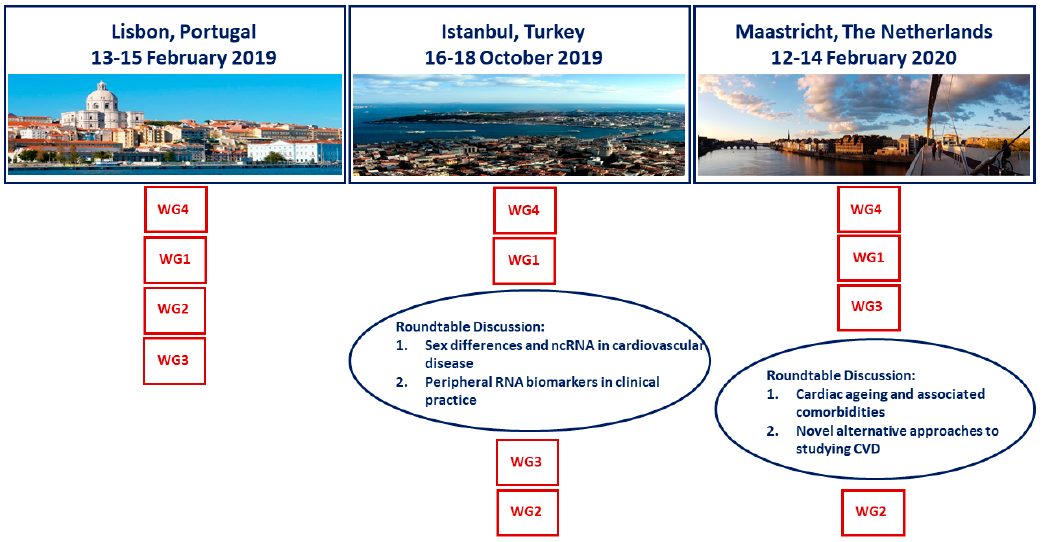
Figure 2. Organisation and evolution of the EU-CardioRNA COST Action working group meetings Feb 2019–Feb 2020. The order of sessions chronologically is demonstrated by the vertical order.